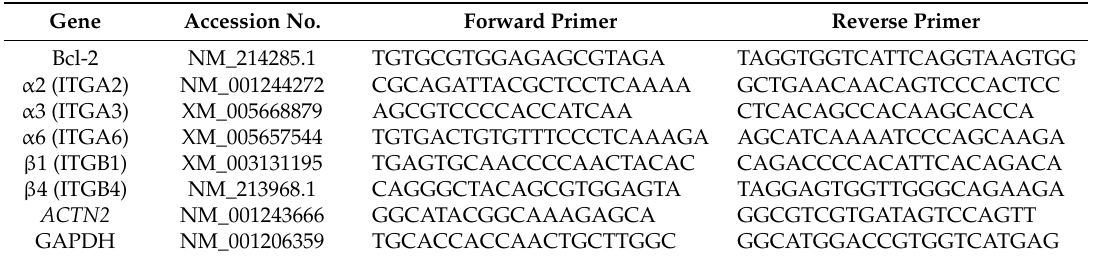
Table 2. Primer sequences of different genes.